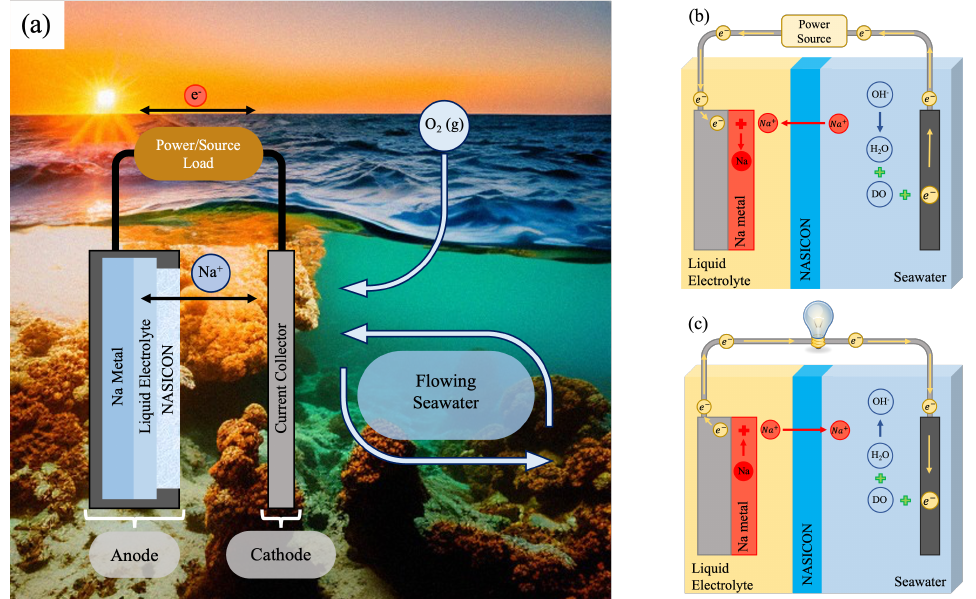
Figure 1. Scheme of a seawater battery (SWB) cell ( a ) structure and operating mechanism during the ( b ) charge and the ( c ) discharge